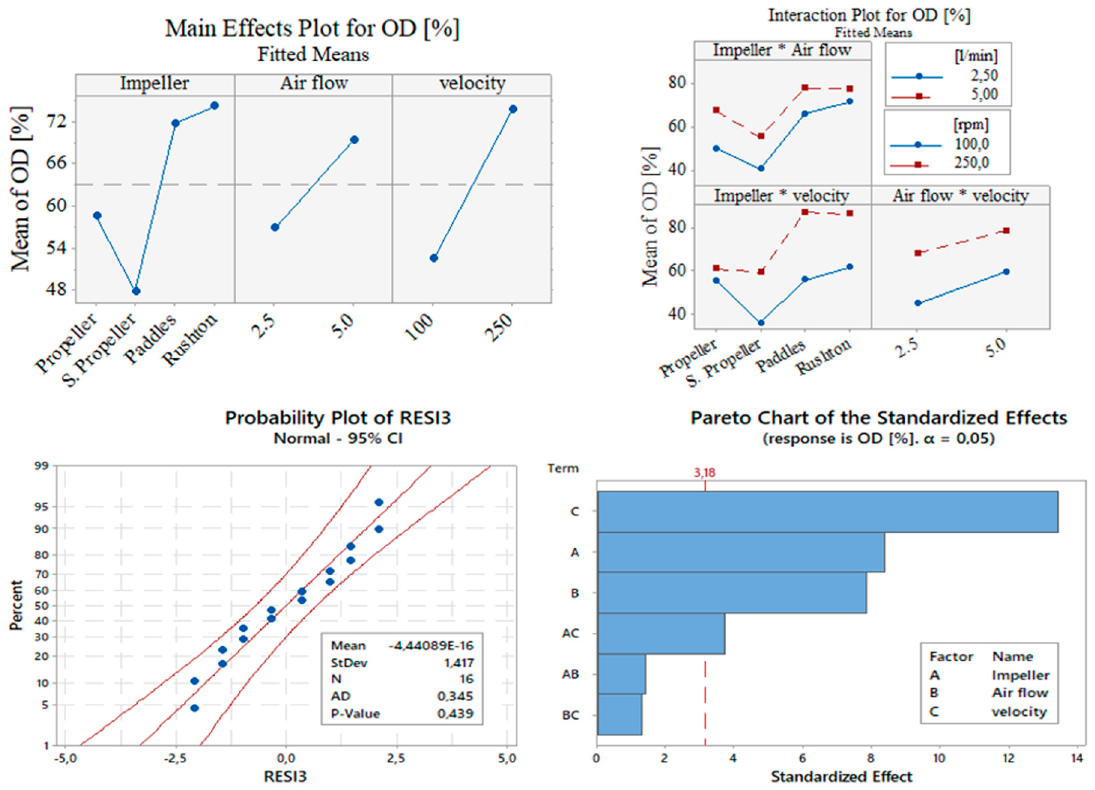
Figure A3. Statistical analysis: ( top left ) the main e ff ects of dissolved oxygen, where the velocity label Figure A3 . Statistical analysis: (top left) the main effects of dissolved oxygen, where the velocity label corresponds with agitation velocity [RPM] and the airflow has units of [L / min]; ( top right ) interaction corresponds with agitation velocity [𝑅𝑃𝑀] and the airflow has units of [𝐿/𝑚𝑖𝑛] ; (top right) e ff ects for oxygen dissolved; ( bottom left ) data homoscedasticity; and ( bottom right ) Pareto chart of interaction effects for oxygen dissolved; (bottom left) data homoscedasticity; and (bottom right) the standardized e ff Pareto chart of the standardized effects.